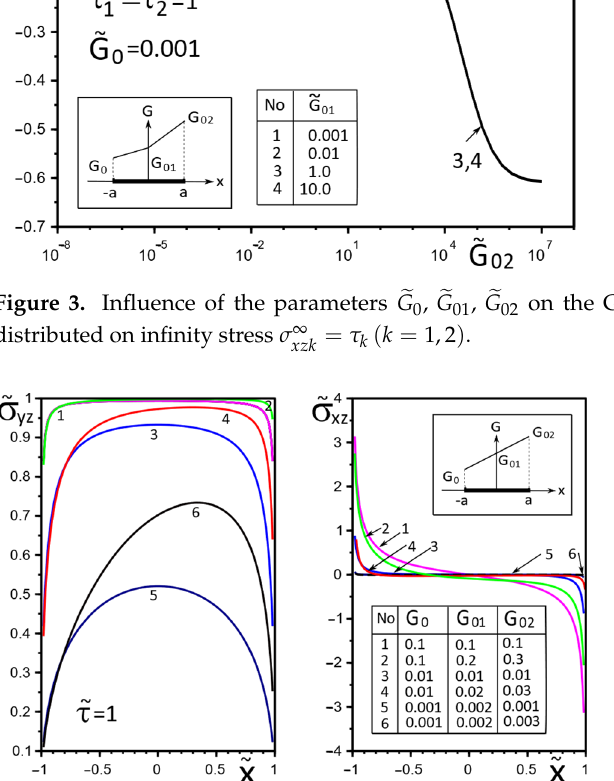
Figure 4. Stress distribution along with the upper interface (inclusion–matrix half-space S 2 ) with a linear distribution of material stiffness.